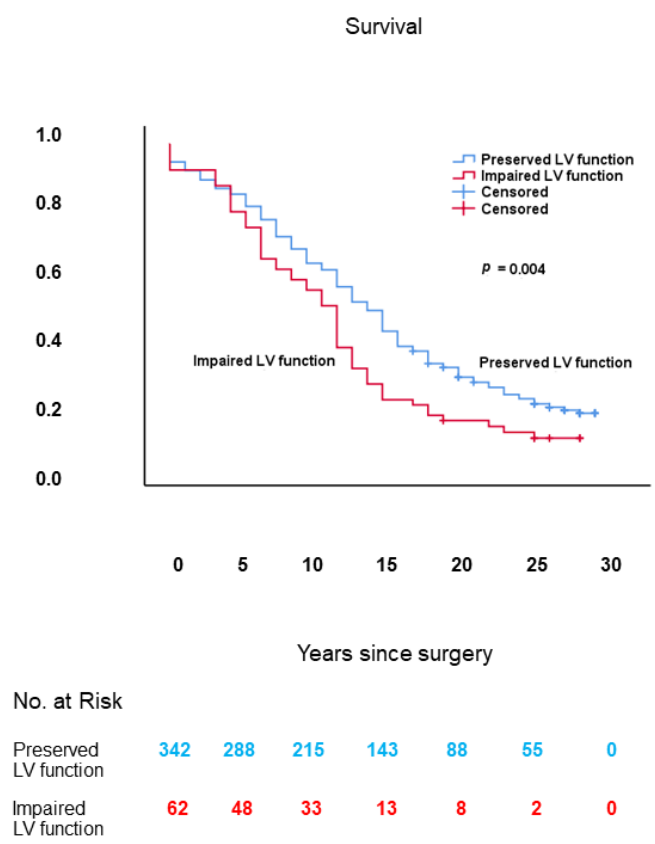
Figure 1. Kaplan–Meier survival curves, from date of surgery, of patients with impaired vs. those with preserved LV function. LV: left ventricular.